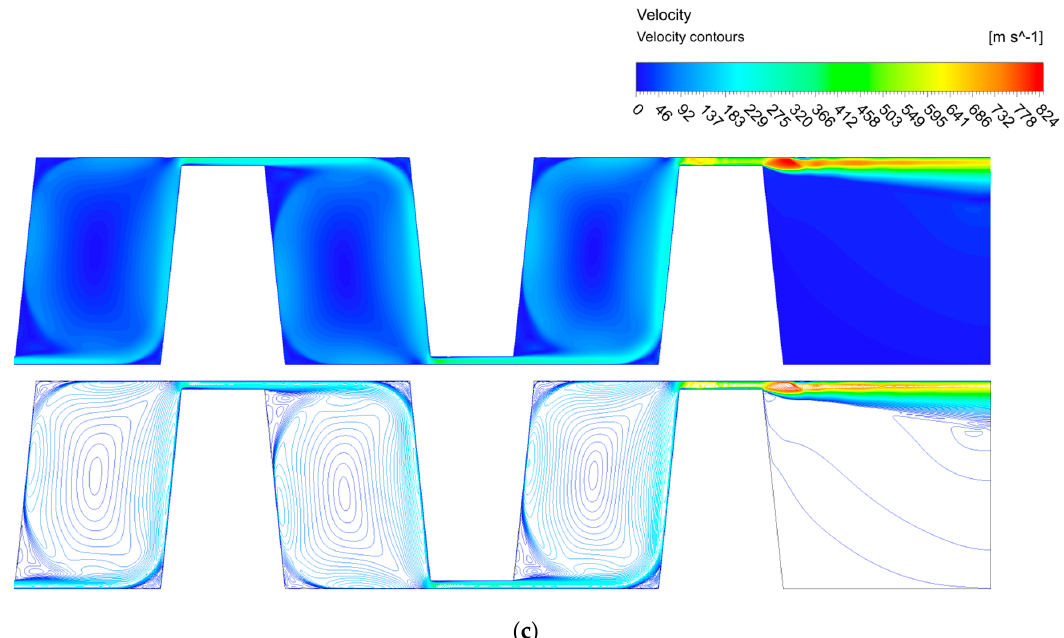
Figure 10. Velocity contours inside the tooth interlocking labyrinth with 1 mm ( a ), 2 mm ( b ) and 3 mm ( c ) basis thickness.